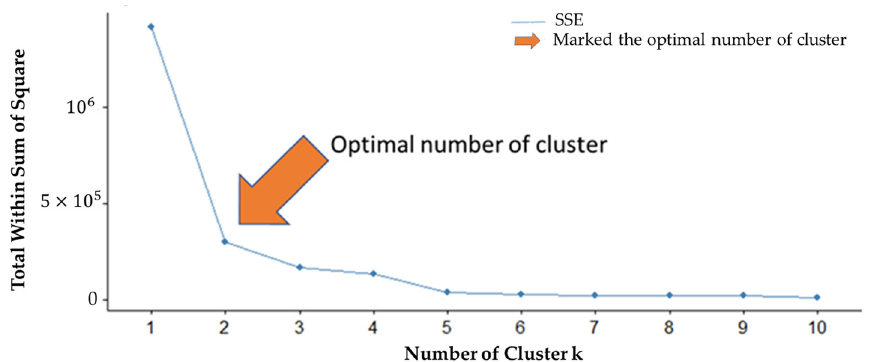
Figure 2. Selection of the optimal number of clusters using the elbow method.